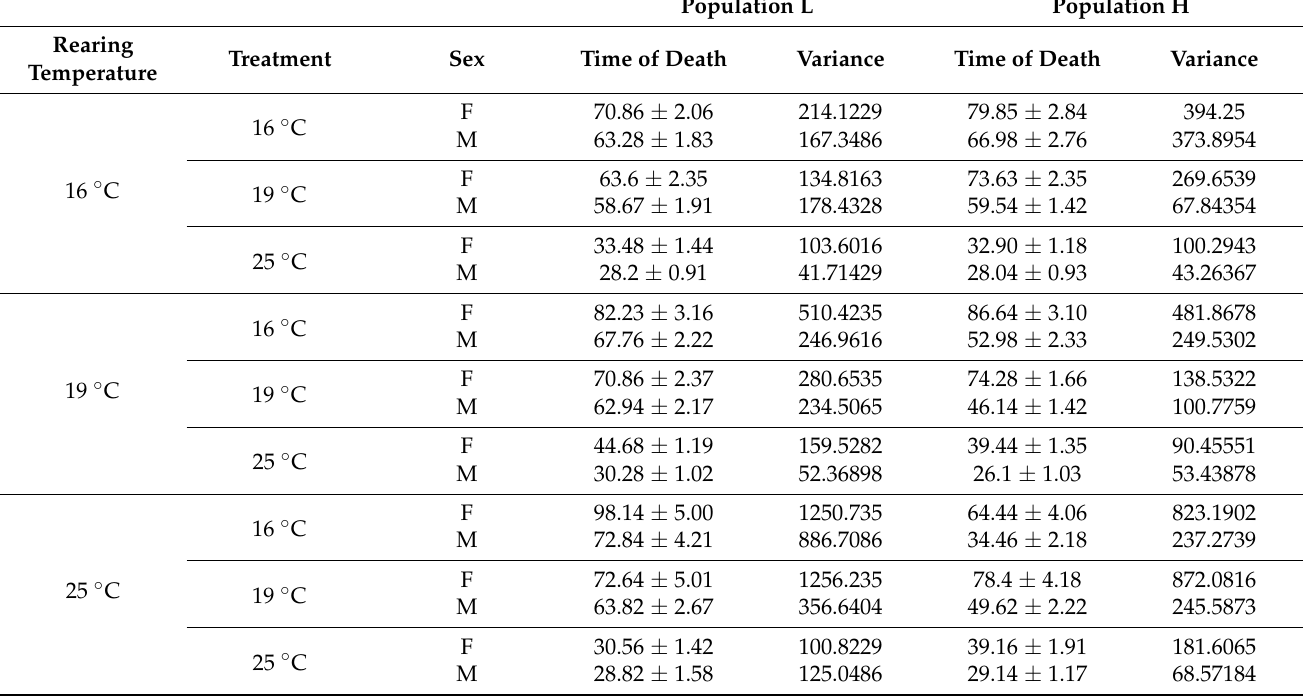
Table 1. Mean values with standard errors and variance for all groups for a time of death (measured in hours) under desiccation stress. Population L—population originating from lower altitude; popu- lation H—population originating from higher altitude; rearing temperature—T at which flies evolve in the laboratory; treatment—T at which flies were tested for desiccation resistance; F—females; M— males; time of death—mean value ± SE (standard error). This Table was published in the Proceedings of the 1st International Electronic Conference on Entomology , 1–15 July 2021, doi:10.3390/IECE-10532. Population L Population